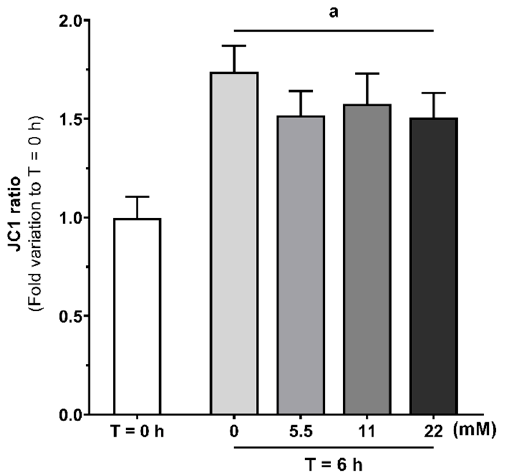
Figure 5. Evaluation of human spermatozoa mitochondrial membrane polarization at baseline (T = 0 h) and without or with glucose (0, 5.5, 11 and 22 mM) stimuli following 6 h in capacitation conditions, using the dye JC-1. Results are expressed as mean ± SEM ( n = 15 for each condition). Significantly different results are expressed as: ( a ) Relative to T = 0 h group.